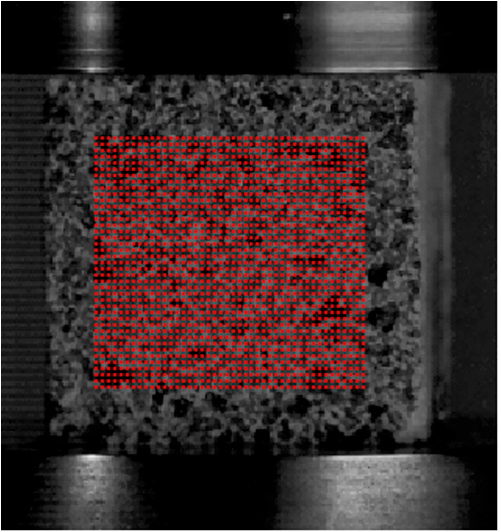
Figure 11. Lattice of reference points (the number of reference points is 1804; the spacing between the adjacent reference points is 3 pixels; the reference subzone is a square of 21 pixels in each edge, and the object subzone is four times the size of reference subzone).